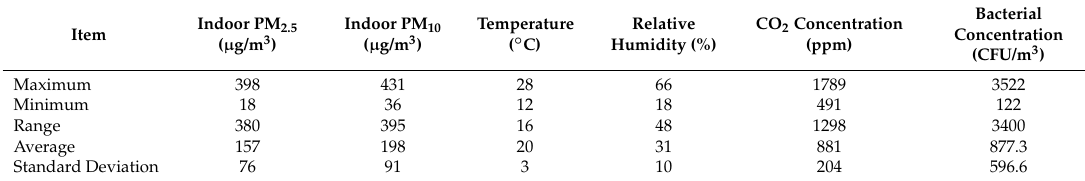
Table 1. Descriptive statistics of variables for the 249 measured data